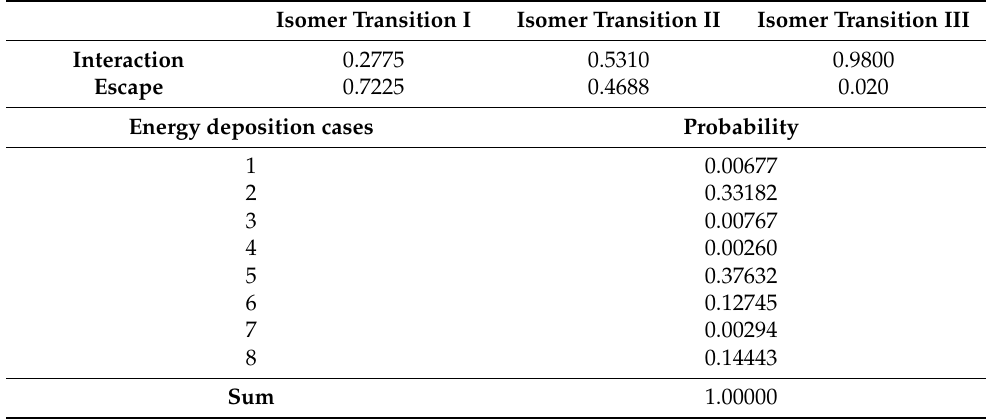
Table 5. Relative intensity calculation by energy deposition case for configuring the spectrum.